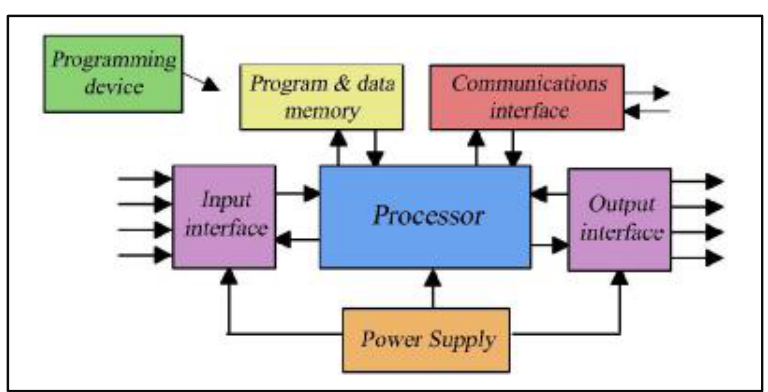
Fig. 1. The PLC system